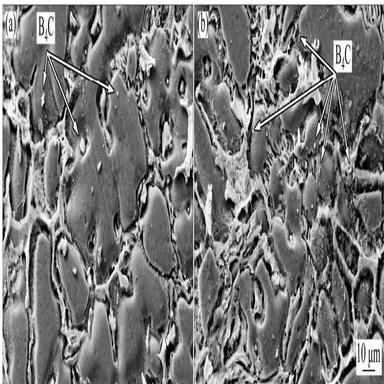
ESEM micrographs of stir cast AA2124/4wt.%B4C nano-composite